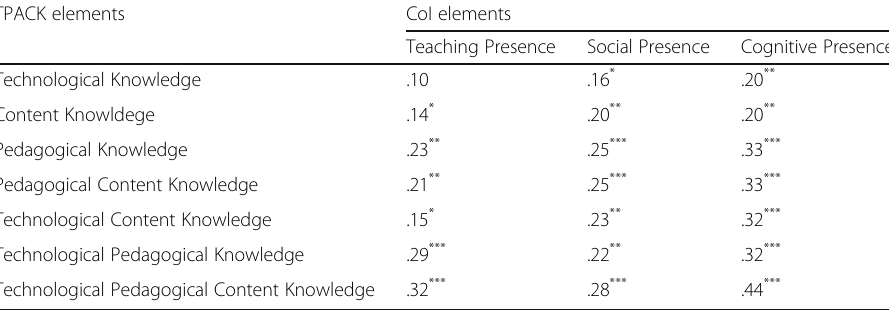
Table 4 Pearson ’ s correlation coefficients between TPACK and CoI elements ( N = 217) TPACK elements CoI